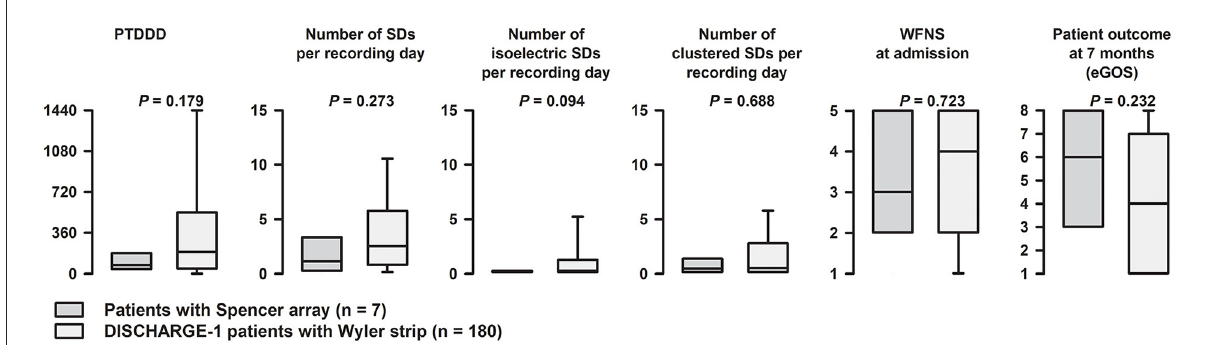
FIGURE4 Comparison of the monitoring quality of Spencer-type electrode arrays and Wyler-strips. In this figure the four different SD variables were compared between Spencer-type electrode arrays ( n = 7 patients) and Wyler-strips ( n = 180 patients from the DISCHARGE-1 trial). There was a tendency for patients in the present study to be slightly less affected than patients in DISCHARGE-1, but this concerned not only SD variables but also WFNS at admission and eGOS at 7 months. Importantly, no significant differences were observed. eGOS, extended Glasgow Outcome Scale score at 3–6 months; PTDDD, peak total SD-induced depression duration of a recording day in minutes; WFNS, World Federation of Neurosurgical Societies